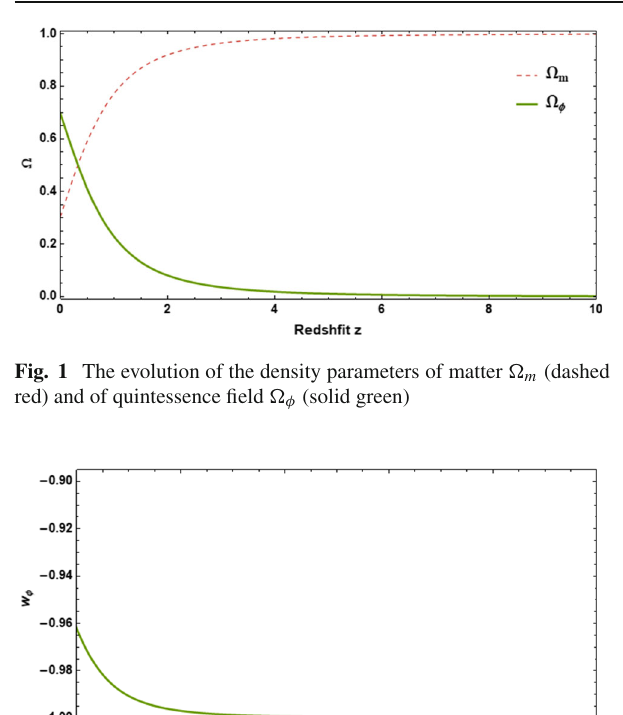
r [55], we choose 10 9 A (cid:5) = 2 . 105 ± 0 . 030 and r = 0 .